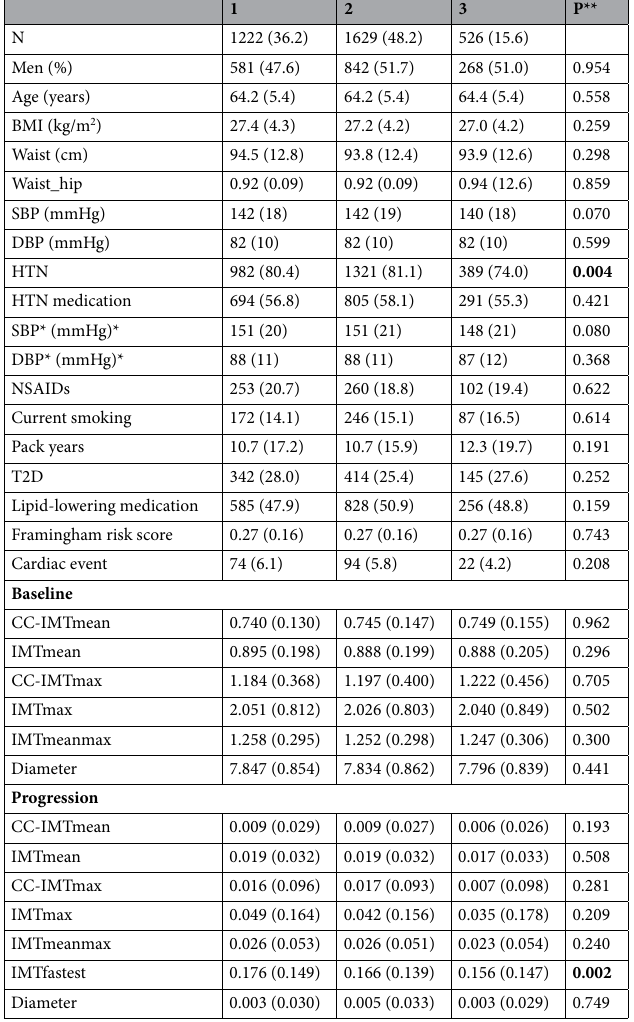
Table 2. Demographic characteristics of the IMPROVE participants, by cluster (MAF > 10%). Highlighted in bold are the significant (p < 0.05) differences between groups. Where: *, adjusted to provide estimates of treatment-naïve levels as per Ehret et al.; Statistical analyses compared levels or frequncies across groups 1, 2 and 3. Ungrouped (.) were omitted from the analyses). ** P for Pearsons chi square for categorical variables and Kruskal–Wallis for continuous variables; na, not